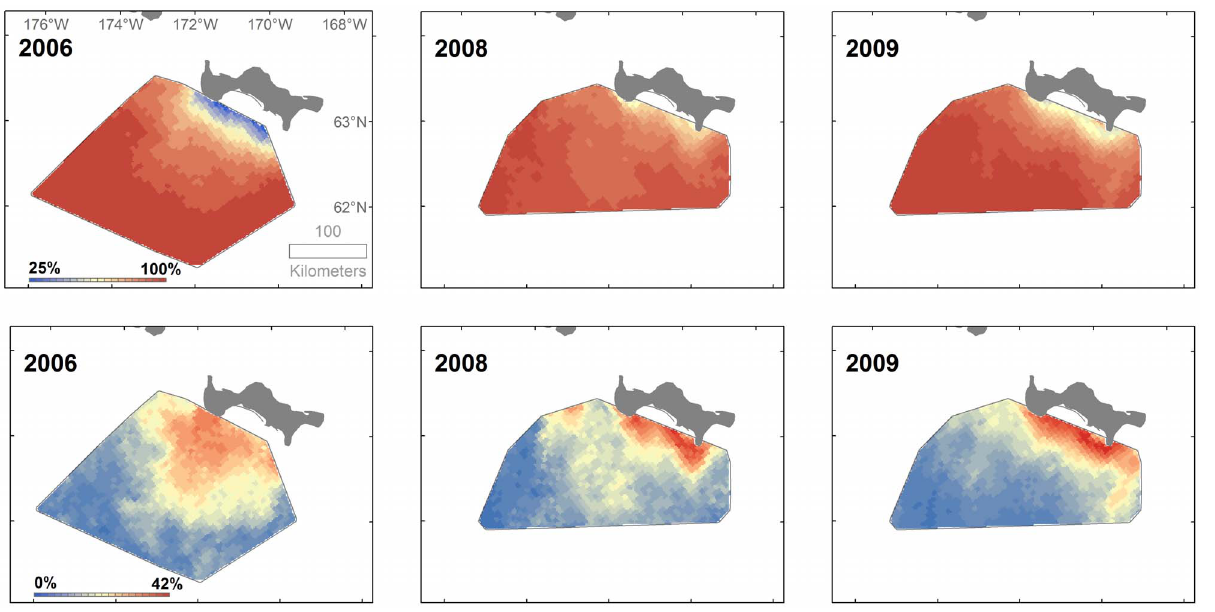
Figure 4. Mean (top row) and sample standard deviation (bottom row) daily sea ice concentration (%). Means and standard deviations were calculated for each 2 km 6 2 km cell within the benthic sampling areas in 2006 and 2008–2009 during walrus tracking periods (tracking periods indicated in Table 1).